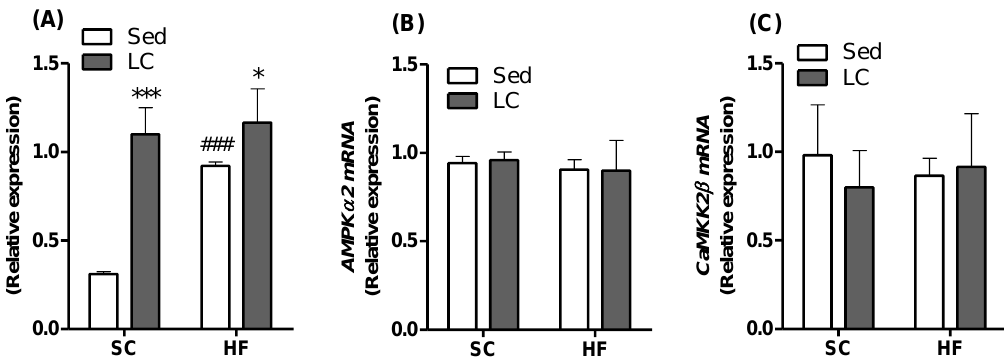
Figure 5. The effects of 8 weeks of LC on the gene expression of Rac1 ( A ), AMPKα2 ( B ), and CaMKK2 β ( C ) in the gastrocnemius muscles of mice fed either SC or HF diet. Data presented as relative mRNA expression. Two-way ANOVA with Bonferroni posthoc test (n = 4). * p < 0.05, *** p < 0.001 vs. respective sedentary (Sed) group; ### p < 0.001 vs. respective standard chow (SC) group.